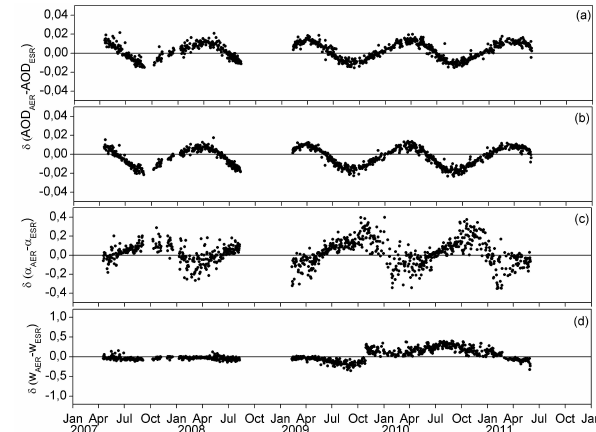
Fig. 1. Evolution of AERONET retrieved AOD at 440nm in Bur- jassot (Valencia, Spain) during the period 2007–2011.